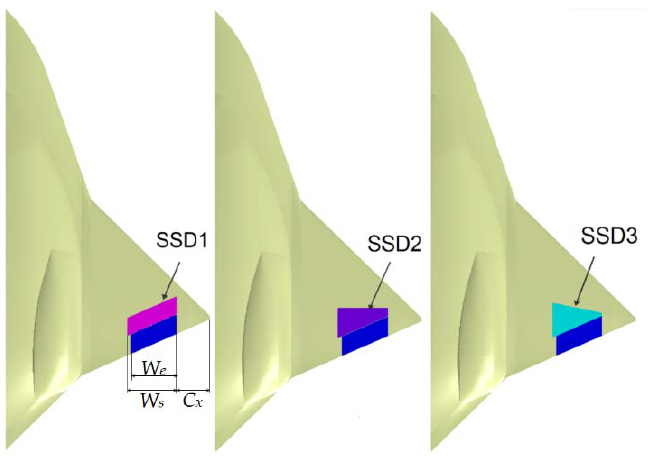
Table 1. Main parameters of the configuration and control surface.